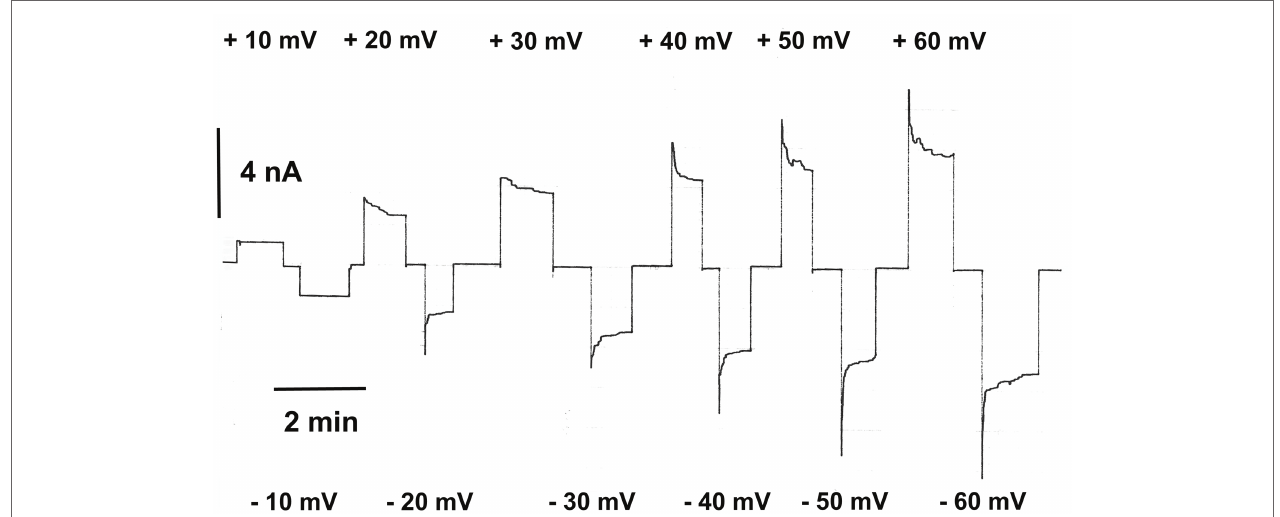
FIGURE 1 | Relaxation of the membrane current in the presence of eukaryotic porin 1 from humans (hVDAC1, Porin 31HL; Benz et al., 1992). The membrane potential was first switched to +10 mV and then to − 10 mV applied to the cis-side of the membrane containing about 50 hVDAC1 pores. Note that the membrane current did not decrease at these voltages. Then, higher positive and negative voltages were applied which resulted in a substantial exponential decrease of the membrane current. The membrane was formed of diphytanoyl phosphatidylcholine/n-decane. The aqueous phase contained 0.5 M KCl (pH 7.2); T = 20 ° C.